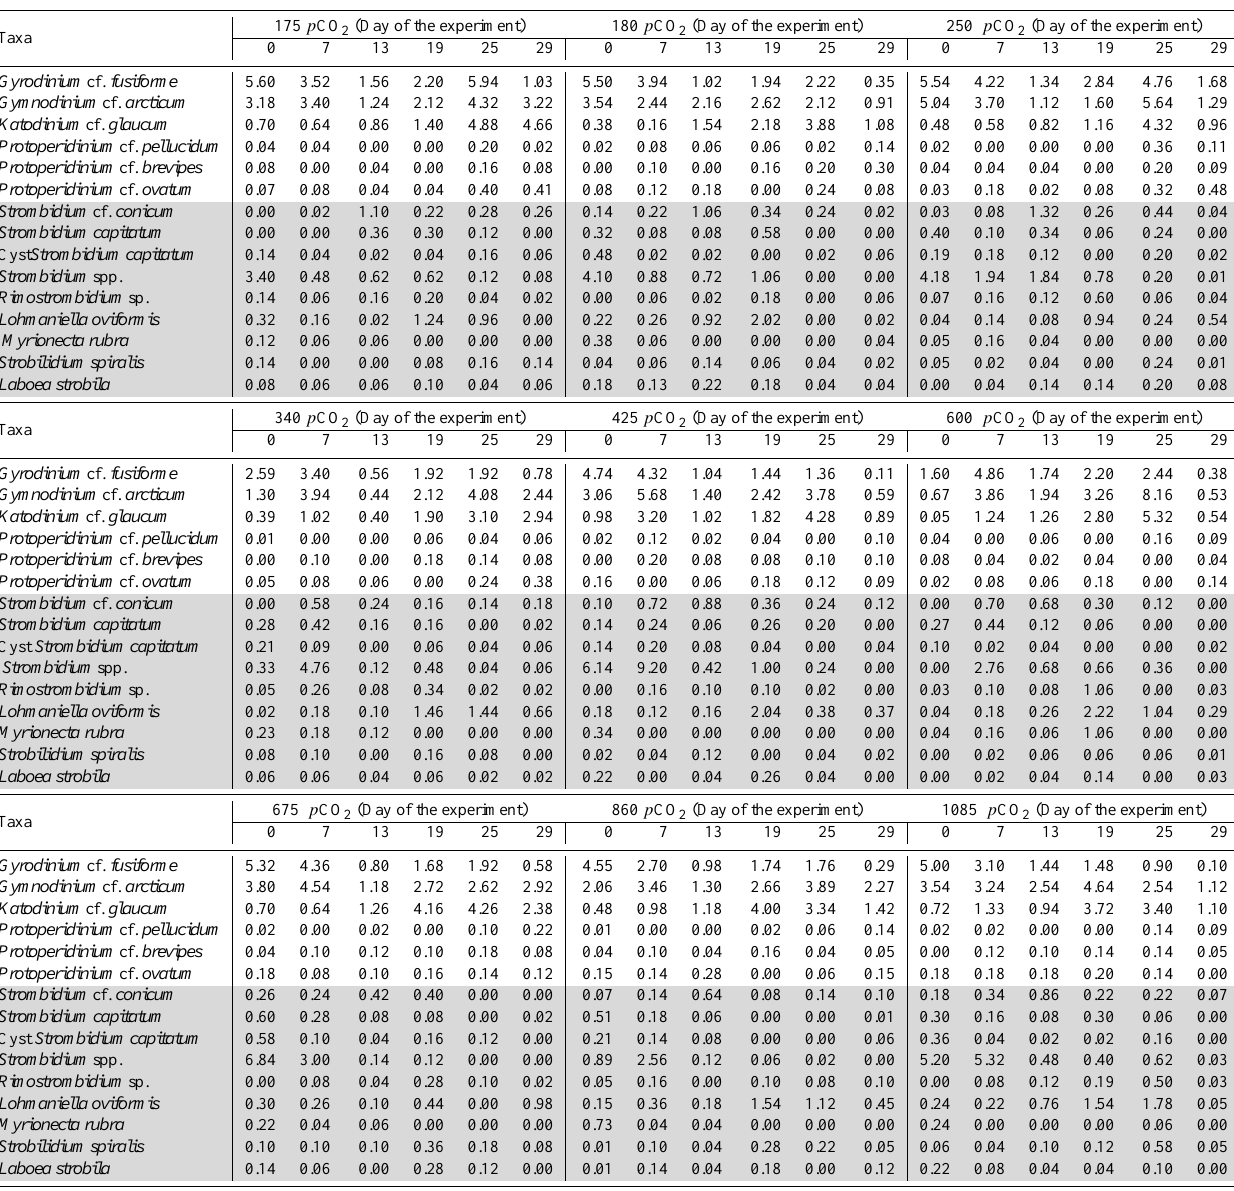
Table A2. Taxonomic composition of microzooplankton (abundance in individuals mL − 1 ) over the course of the mesocosm experiment (white rows: dinoflagellates; light grey rows: ciliates) in the different p CO 2 treatments.